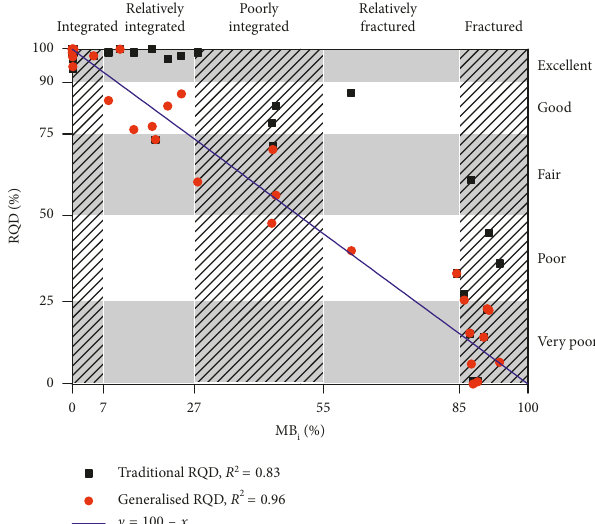
Figure 8: Scatter plot of traditional and generalised RQDs and MB